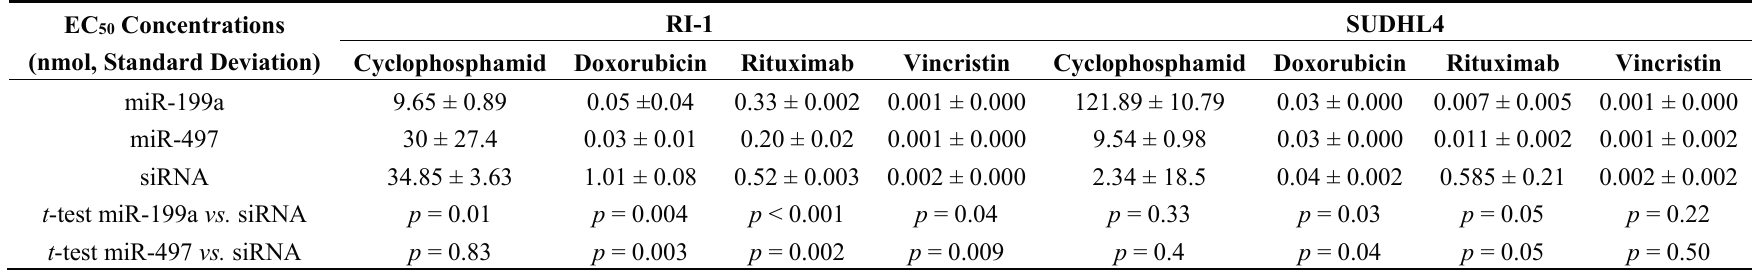
Table 4. EC 50 concentrations of the cell lines RI-1 and SUDHL4 after immunochemotherapy treatment (cyclophosphamide, doxorubicin, rituximab, or vincristine) in miRNA overexpressing cells and controls,